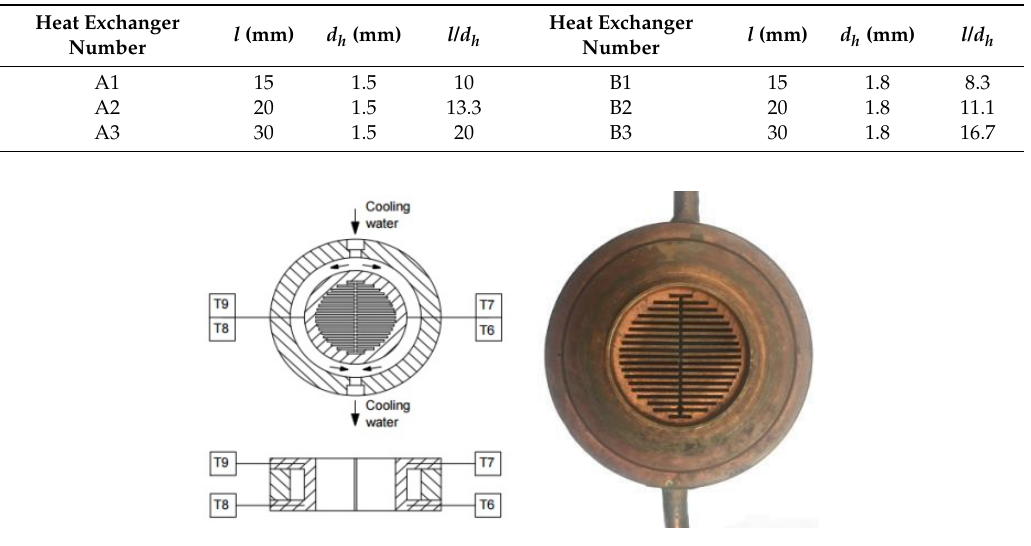
Figure 2. Illustration and photo of a typical tested heat exchanger (A1: l = 15 mm, d h = 1.5 mm, l / d h = 10).